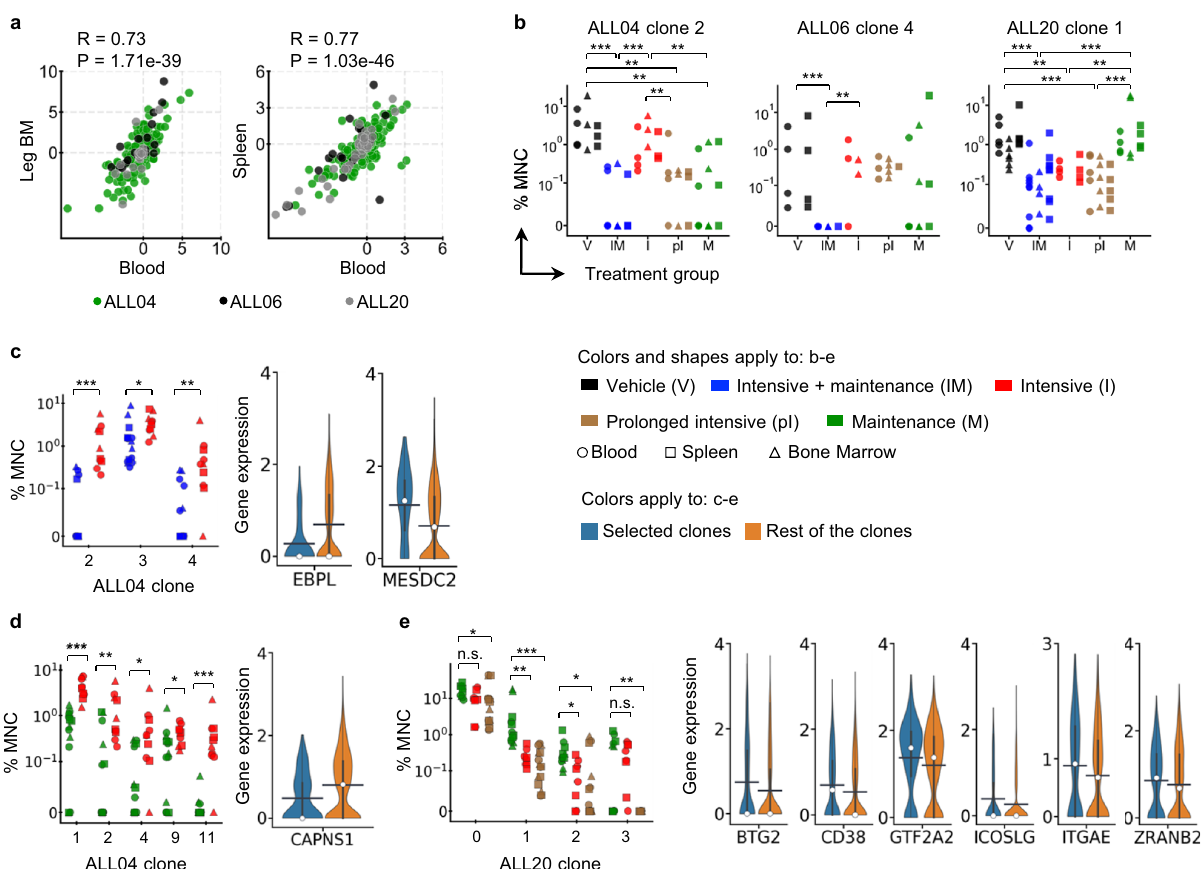
Fig. 5 Some B-ALL clones respond differentially to intensive and maintenance chemotherapy in distinct but consistent manners across multiple mice. a Comparing chemotherapy response of the same clones in different tissues. Shown are the log 2 fold differences between the average clonal abundances of two chemotherapy treatments for each tissue. R Pearson ’ s correlation coef fi cient, P two-tailed P value. Each dot represents one clone. b Example clones that responded differently under various chemotherapy treatments. Each marker represents data from one tissue and one mouse. c Left, ALL04 clones that responded better to combination therapy than to intensive therapy. d Left, ALL04 clones that responded better to maintenance therapy than to intensive therapy. e Left, ALL20 clones that responded better to intensive therapy than to maintenance therapy. b – e P values were calculated by a two-sided Kruskal Wallace test with Bonferroni correction. c – e Right, genes signi fi cantly differentially expressed in the clones shown on the left (blue) compared to all other clones from the same patient samples (orange). The black bar indicates the mean, and the white dot represents the median. BM bone marrow, MNC mononuclear cells. P values were calculated by the one-sided Mann – Whitney U -test and adjusted using both the experimental data and the scramble data, see the Methods section for detail. Source data are provided as a Source Data fi